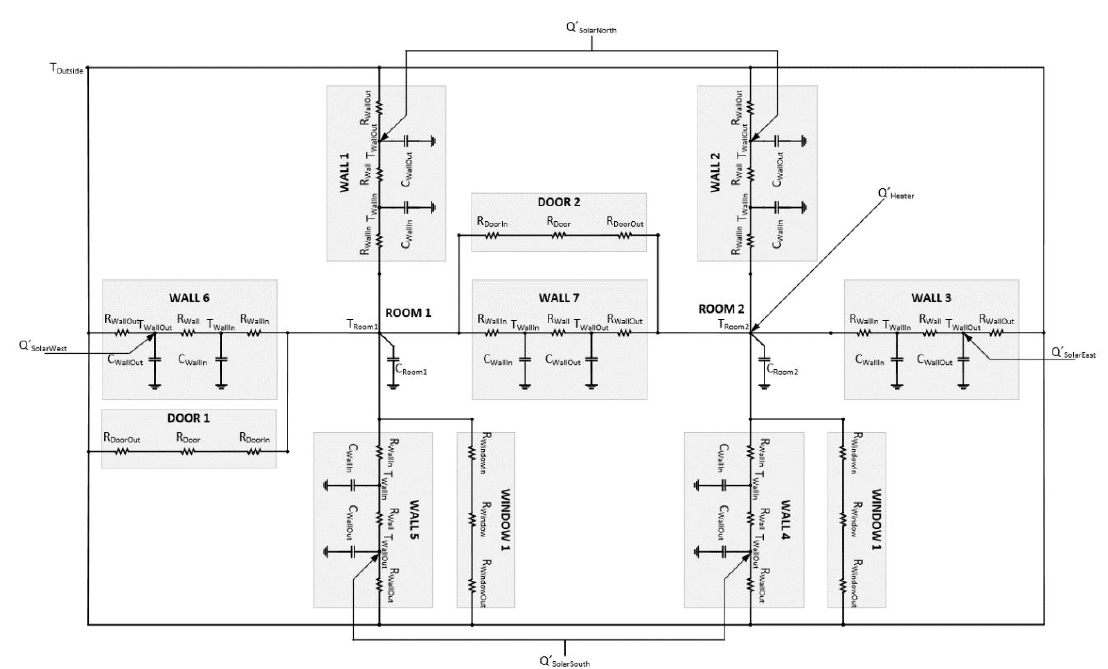
Figure 5. Defining openings with 3R structures and disturbances with current inputs.